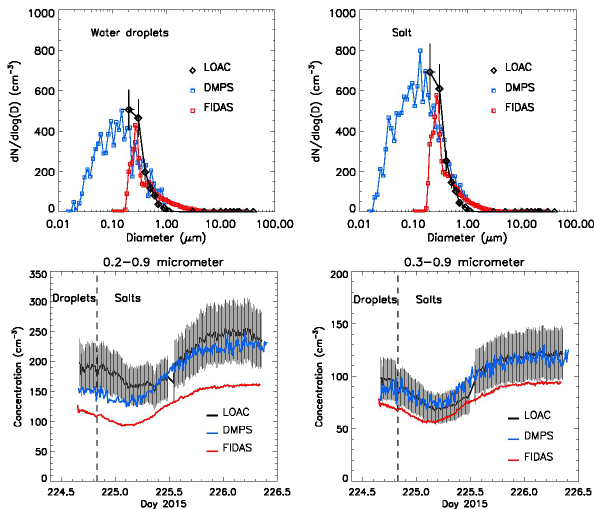
Figure 10. Cross-comparison of LOAC with two other instruments (WELAS and fog monitor) for the total concentrations of aerosols in the size range domain in common, during the ParisFog campaign. The LOAC uncertainties are ± 20%. The peaks of high concentra- tions correspond to fog